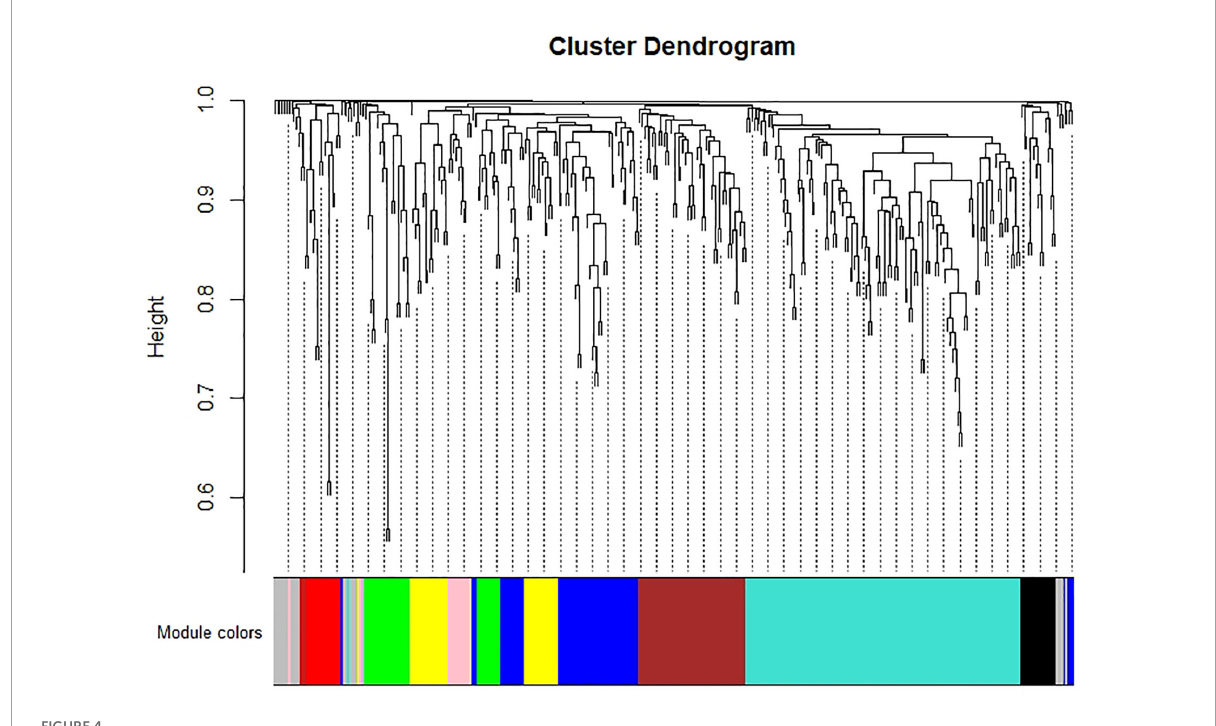
FIGURE4 Hierarchical cluster tree of identified co-expression modules identified by WGCNA. The major tree includes nine modules according to calculation of eigen genes. Each module is highlighted in a designated color.